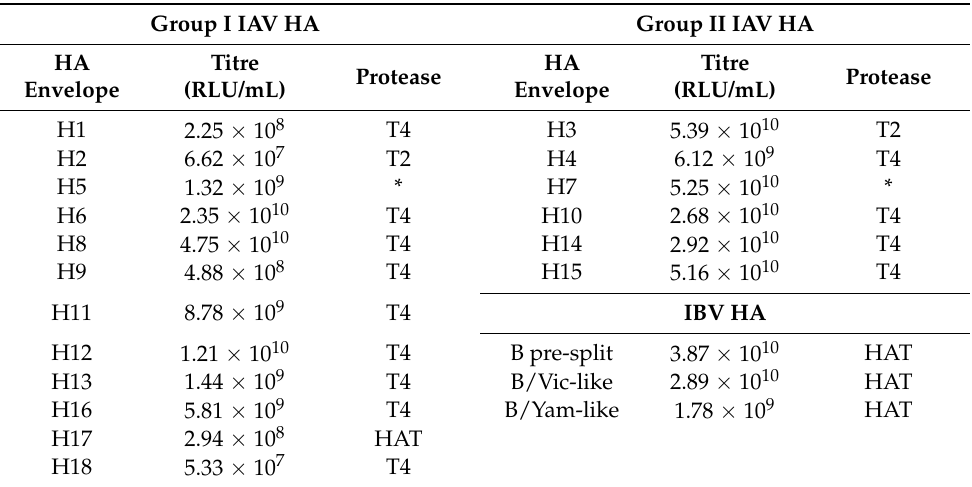
Table 3. Titres in relative luminescence units/mL (RLU/mL) of IAV and IBV hemagglutinin pseu- dotyped viruses as indicated in Figure 3. Protease utilized to achieve the highest titres is indicated. TMPRSS4 is abbreviated to T4 and TMPRSS2 to